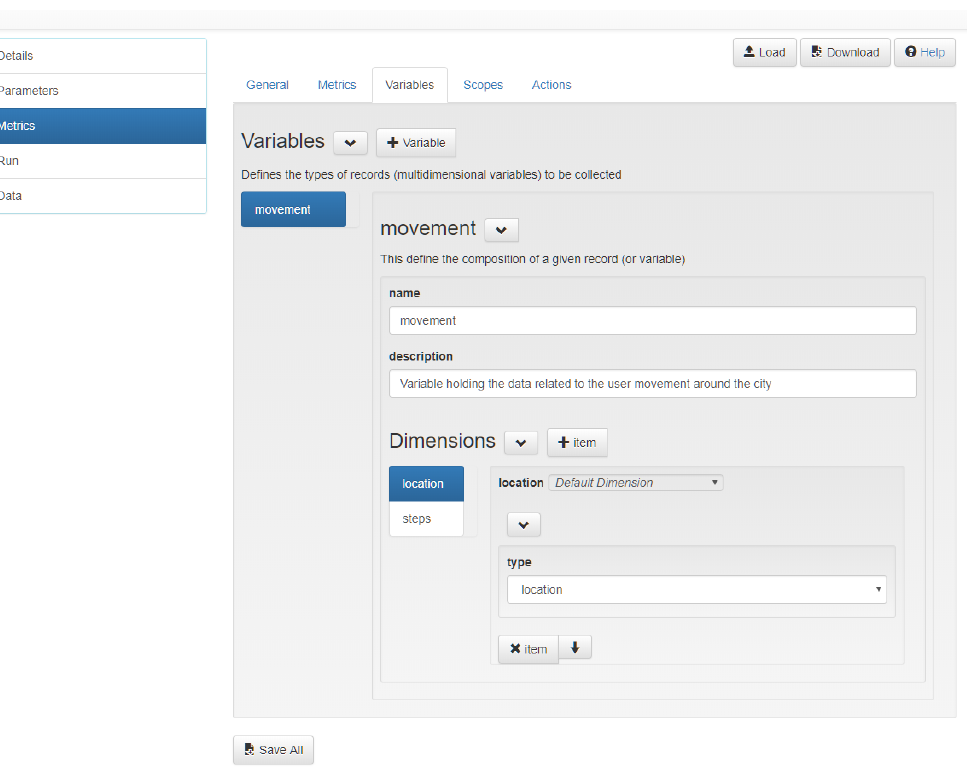
Figure 5. Screenshot of the metrics definition tool (https://gganalytics.geotecuji.org) to specify variables and